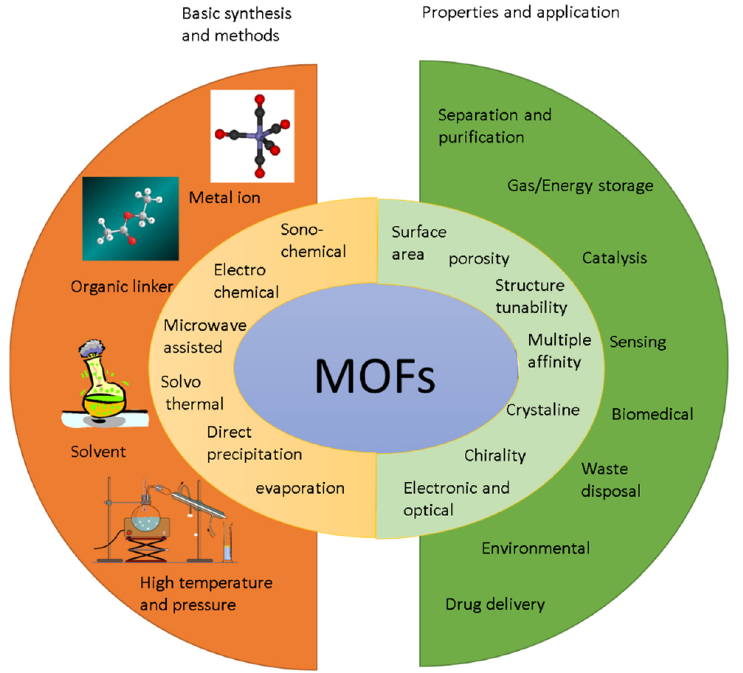
Figure 3. MOF synthesis building blocks, synthesis methods, properties and various applications.